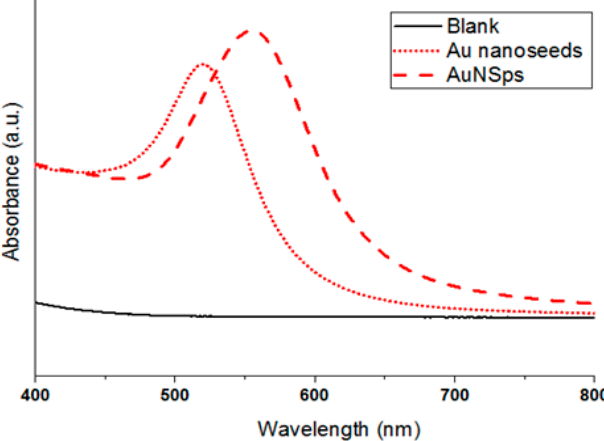
Figure 3. UV-Vis spectra of Au nanoseeds and AuNSps.